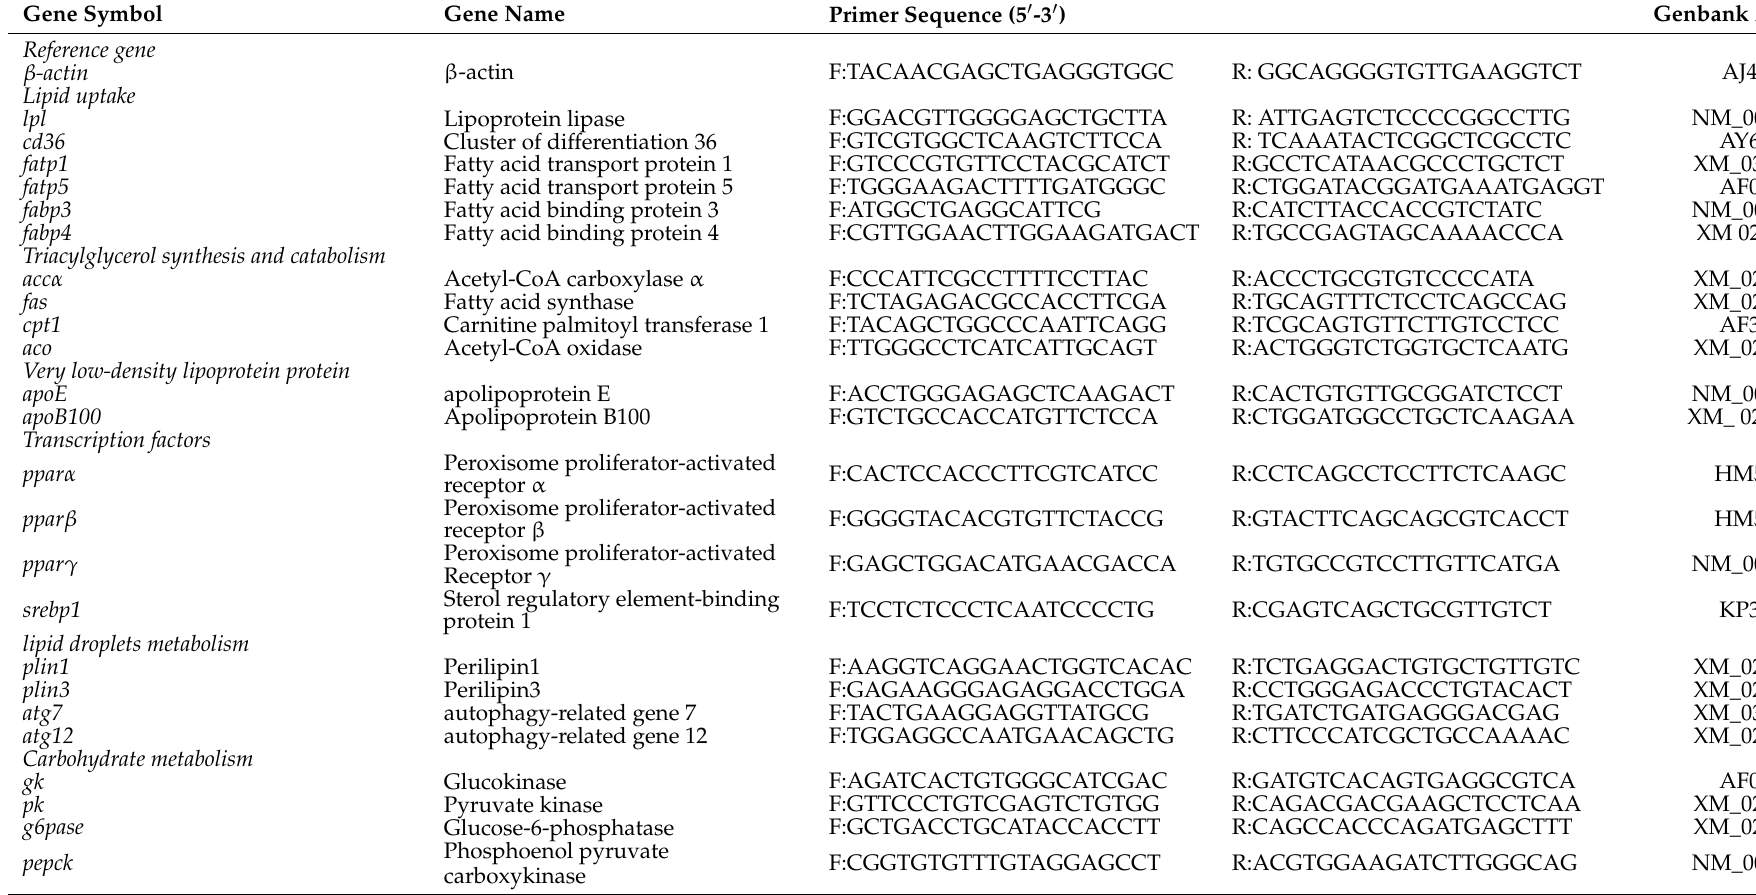
Table 2. Primer sequences for real-time quantitative